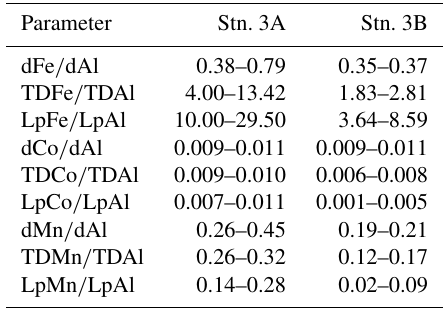
Table 2. TM / Al ratios of different fractions for the repeated deploy- ments at station 3 within the OMZ below 50m water